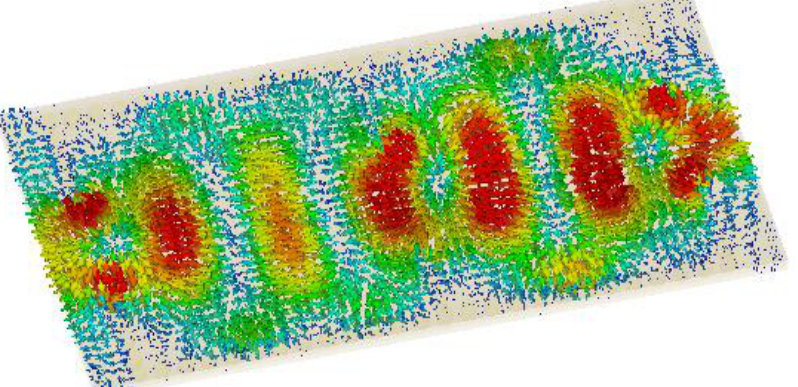
Figure 3. Group delay.